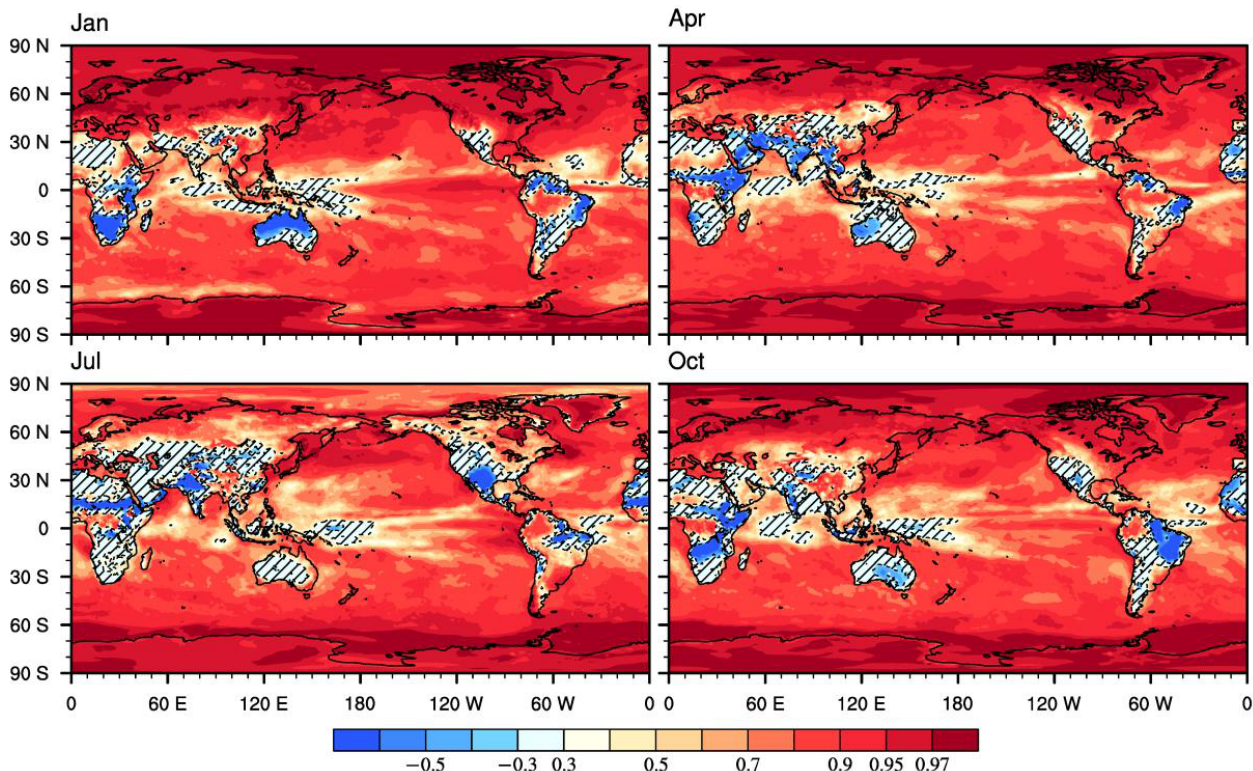
Figure 2. As in Figure 1 but between surface vapor pressure E and surface-air temperature T .